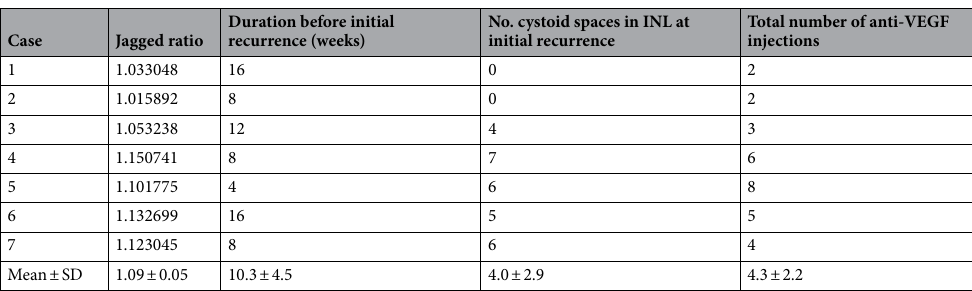
Table 3. Characteristics of seven cases with cystoid spaces only in the outer plexiform layer at the initial visit. SD standard deviation, INL inner nuclear layer, VEGF vascular endothelial growth factor, No.